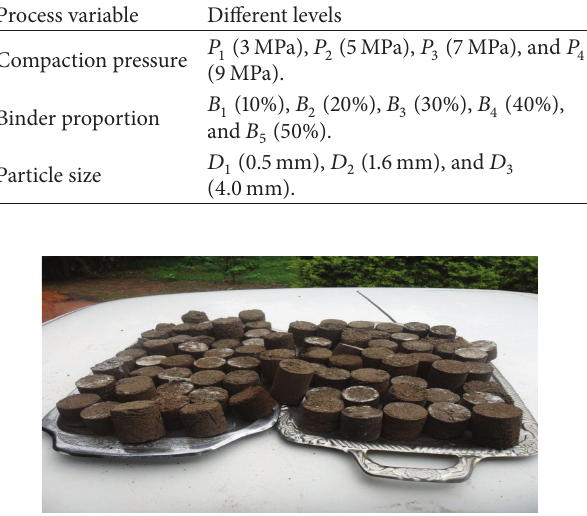
Figure 1: Water hyacinth briquettes.